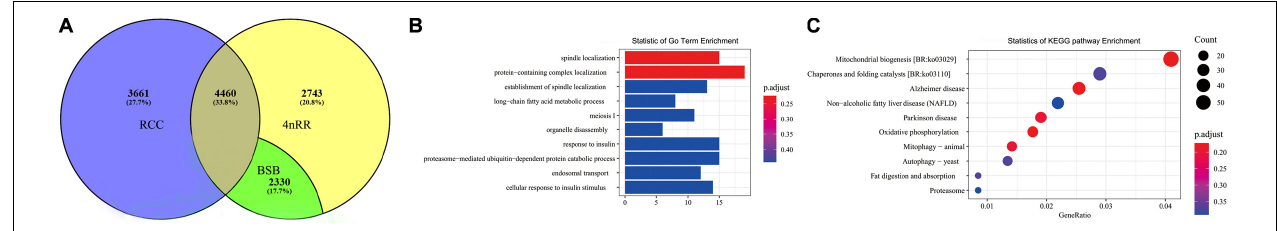
FIGURE 3 | Transcriptome analysis. (A) Annotation genes of Carassius auratus red var. (RCC), Megalobrama amblycephala (BSB), and autotetraploid Carassius auratus (4nRR). (B) The enriched molecular functions of acquired genes in 4nRR. (C) The enriched pathways of acquired genes in 4nRR. TABLE 5 | Annotation of novel genes in different databases in Carassius auratus (RCC) and autotetraploid Carassius auratus (4nRR).